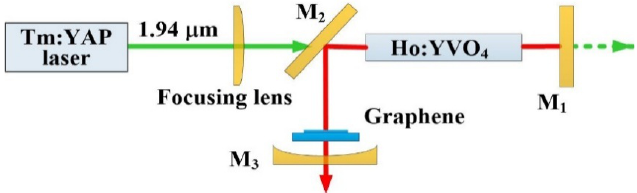
Figure 1. Schematic of the experimental setup.